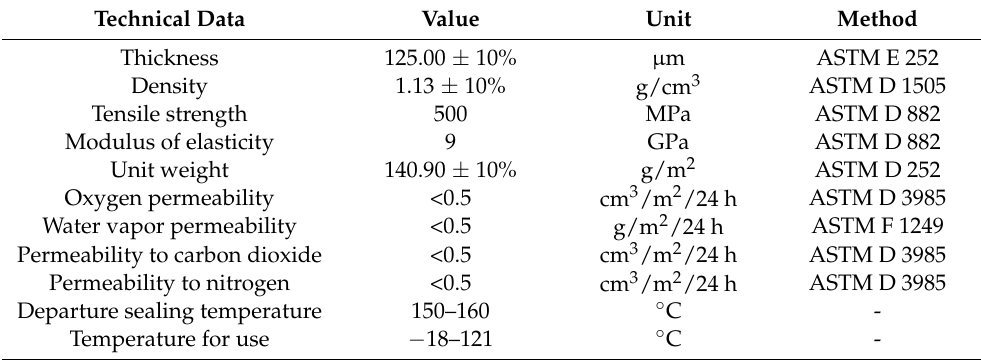
Table 1. Technical data of plastic sheets PET + ALU + OPA STE + PP G. Technical